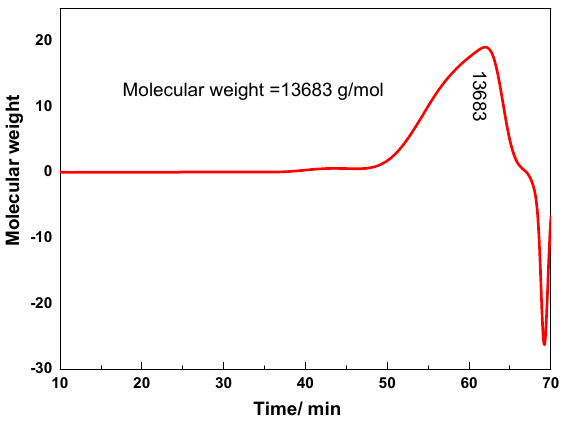
Figure 4. The GPC characterization of SX-1.